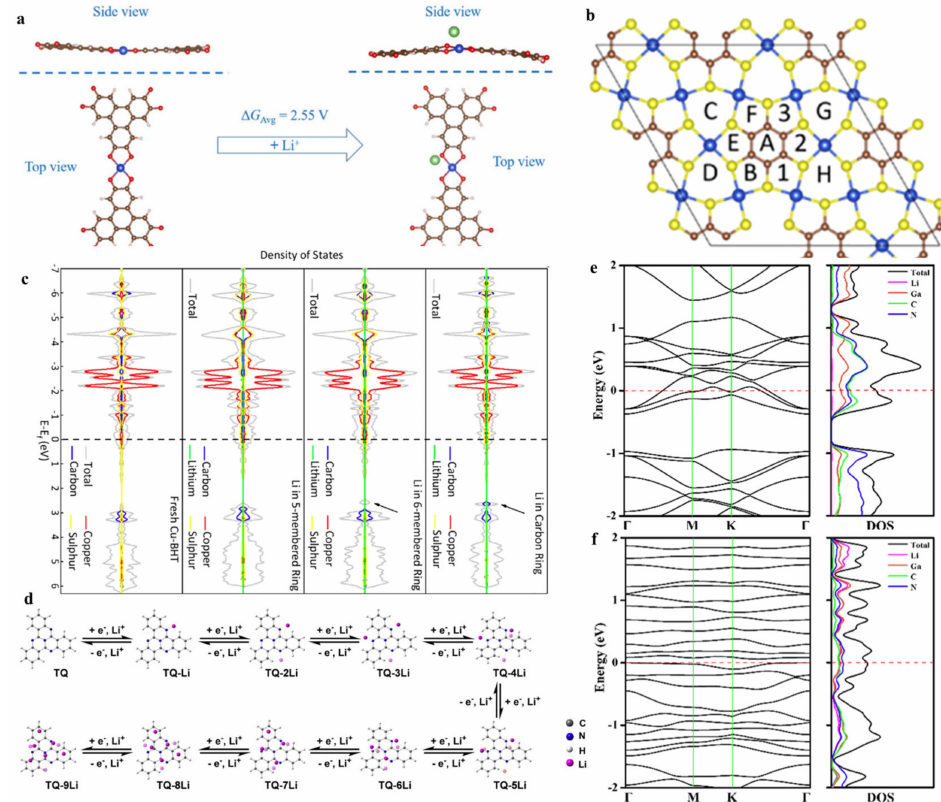
Figure 12. ( a ) Side view and top view of a single unit of relaxed and lithiated Cu 3 (HHTP) 2 framework. The average potential for each lithium-ion insertion was 2.55 V, taking the lithium anode as a reference. The green, red, brown, blue, and white spheres are lithium, oxygen, carbon, copper, and hydrogen atoms, respectively. Reproduced with permission from Ref. [83]. Copyright 2019 Elsevier B.V. ( b ) Fully relaxed 2 × 2 crystallographic structure of the 2D Cu–BHT MOF. The numbers and letters represent different positions for Li + adsorption. C atoms in brown, Cu atoms in blue, and S atoms in yellow, ( c ) total and projected density of states of the fresh Cu–BHT monolayer and 1 Li + loaded in the essential three rings of the Cu–BHT structure. Reproduced with permission from Ref.